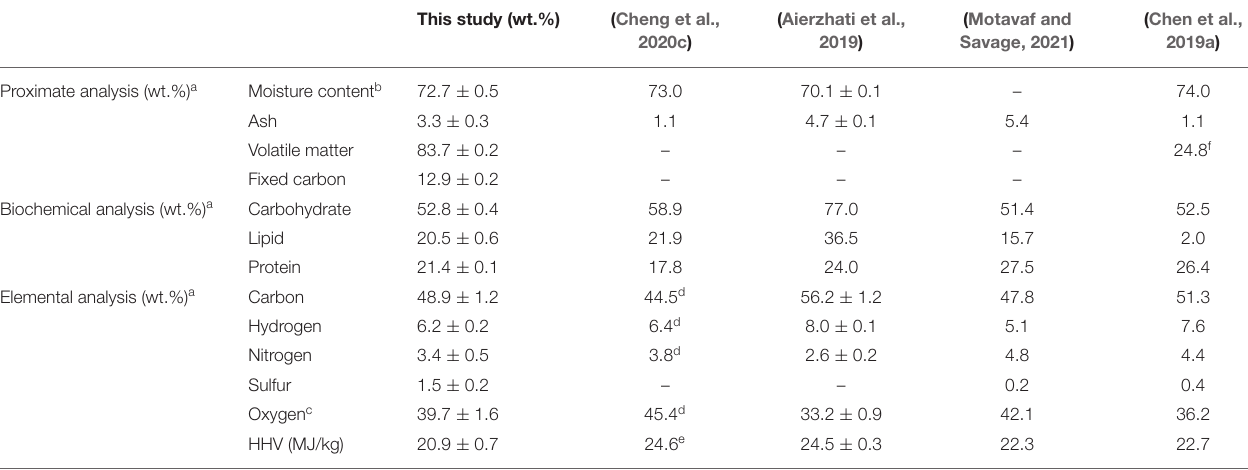
TABLE 1 | Biochemical and elemental composition of food waste feedstock as the mean of at least duplicate analysis. This study (wt.%)